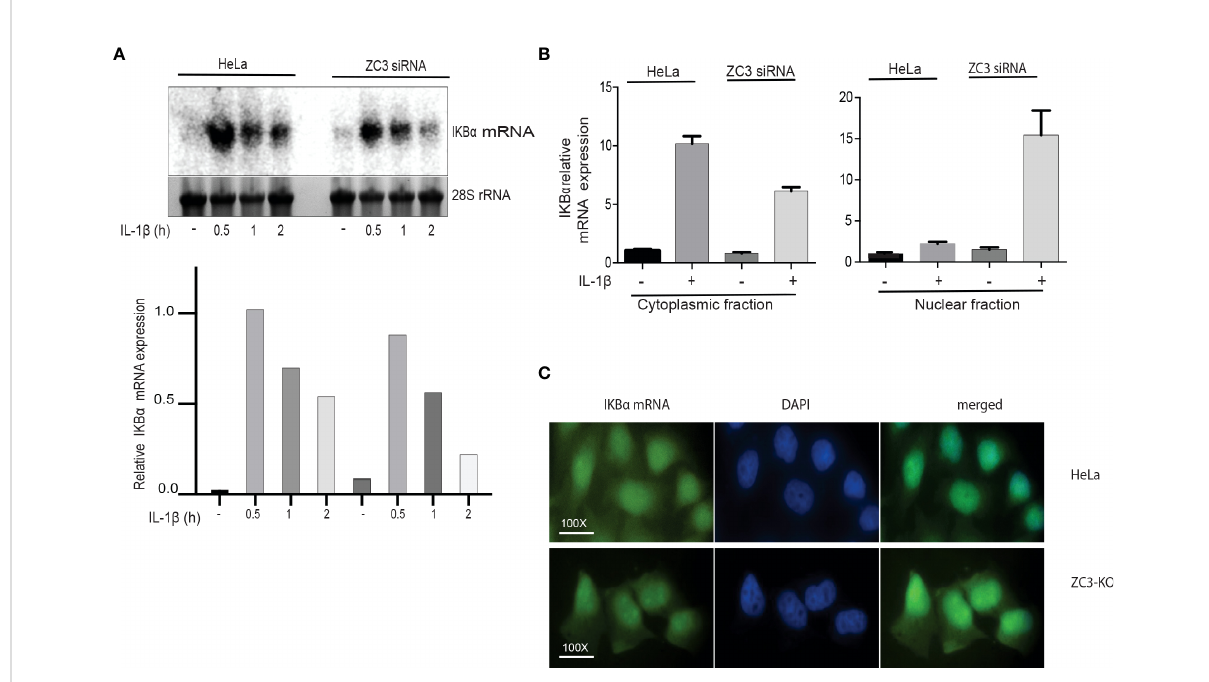
FIGURE 6 Lack of ZC3H11A expression results in an increased nuclear retention of the IkBa mRNA. Northern blot analysis of IkBa mRNA accumulation in total cytoplasmic RNA isolated from HeLa cells treated with ZC3 siRNA or scramble siRNA cells then treated with IL-1b for three time points. The 28S rRNA served as a loading control (A) . RNA from HeLa cells treated with ZC3 siRNA or scramble siRNA treated or untreated with IL-1b were fractionated into nuclear and cytoplasmic fractions. The relative expression of IkBa mRNA was quantitated by RT-qPCR (B) . Fluorescent in situ Hybridization (FISH) for Hela cells or ZC3-KO cells using an Alex 488-labeled oligonucleotide probe complementary to the coding sequence of IkBa mRNA (C)